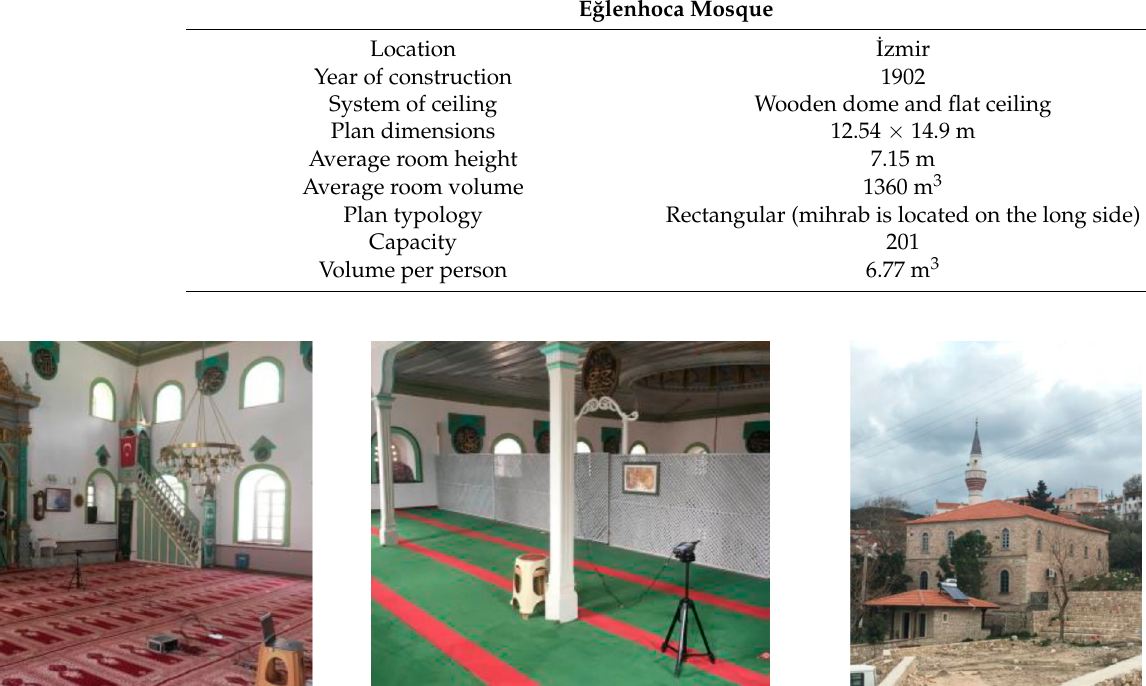
8 Figure 5. Main and women’s prayer hall of Attar Ece Mosque (photos by the authors). 3.5. E ğ lenhoca Mosque The mosque, built in 1902 in İ zmir, has a longitudinal rectangular plan. The ceiling system consists of a central wooden dome and a wooden flat ceiling. The inner surface of mihrab is covered by wooden materials. The mimbar of mosque is also wooden. The women’s hall is visually separated from the main prayer hall using perforated wooden panels. The women’s prayer hall is supported by wooden pillars and expanded towards the main worship area. There are wooden, plaster and stone decorations inside. There are wooden decorations on the wooden dome, which is an element of the upper cover struc-